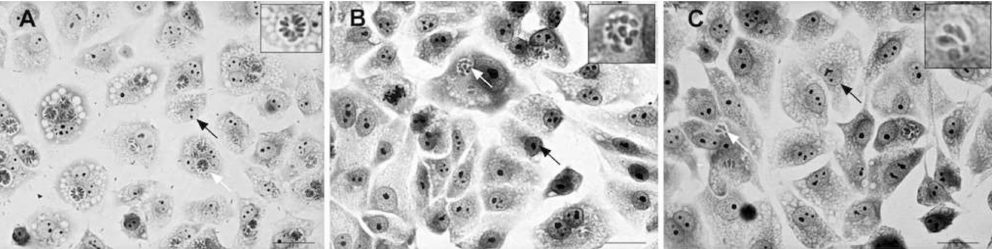
Figure 3. Optical microscopy of the biological test showing infected LLC-MK2 cells. The black arrows point to the cell nucleus; the white arrows indicate the parasitophorous vacuole. ( a ) Control case. Reduction of infection with the elimination of the parasite in the cells treated with ( b ) compound 1 and ( c ) 7